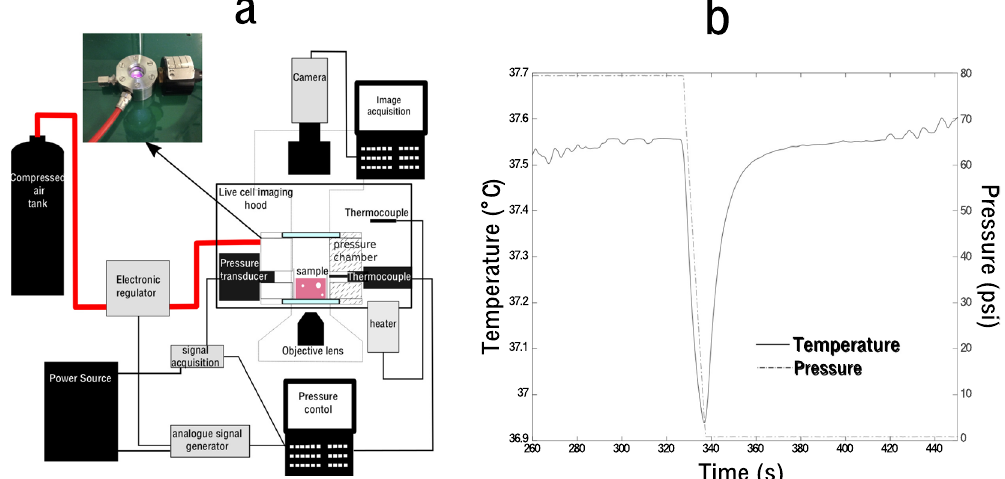
Figure 1. ( a ) Showing the experimental set up of the pressure chamber, with an image showing the chamber in working configuration, ( b ) showing the change in temperature with pressure variation in the